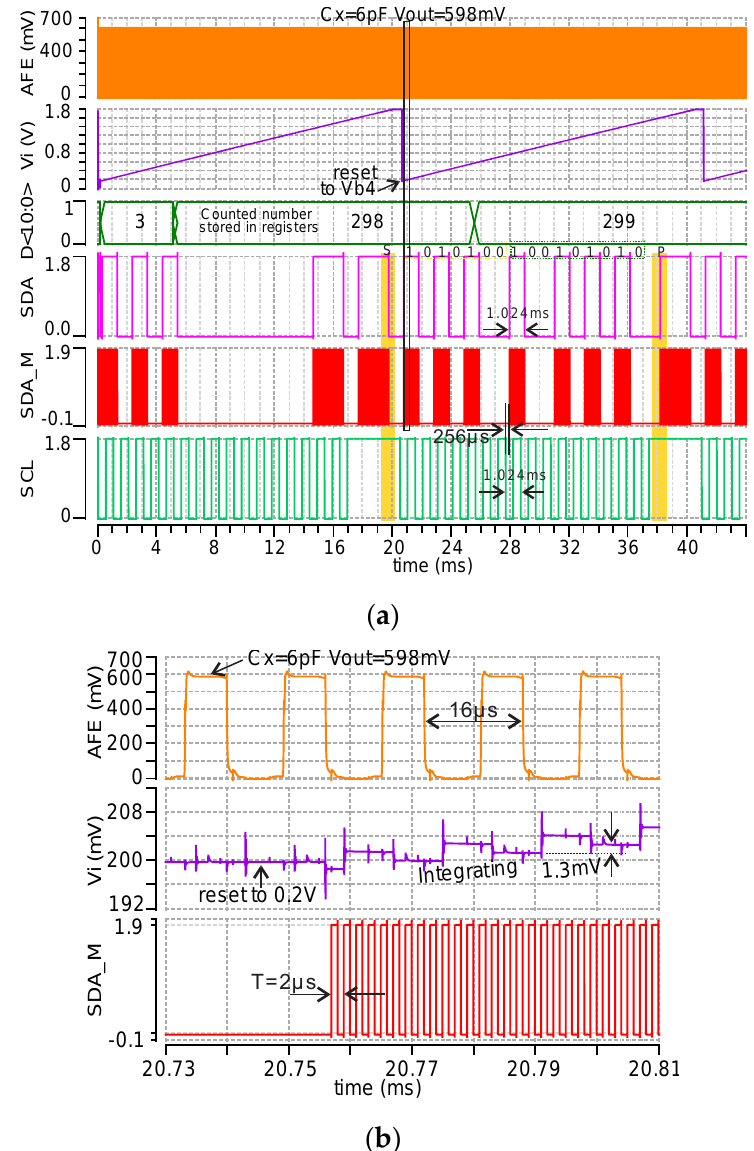
Figure 14. ( a ) Post layout simulation of ADC together with AFE and I2C when the capacitive MEMS pressure sensor (Cx) = 6 pF. The C-V output voltage is 0.59 V and the ADC digital decimal output is 299. ( b ) Zoom of AFE output, Vi (Integrator output), and SDA_M from 20.73 to 20.81 ms in ( a ). The simulated rms total current consumption is 180 uA.